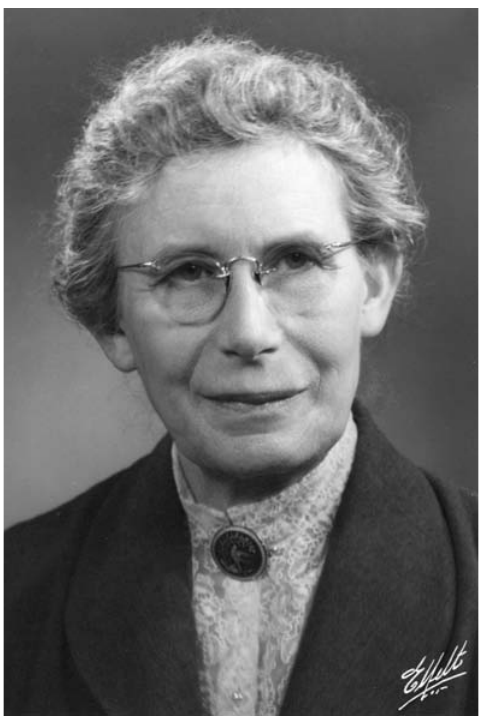
Fig. 1. Inge Lehmann